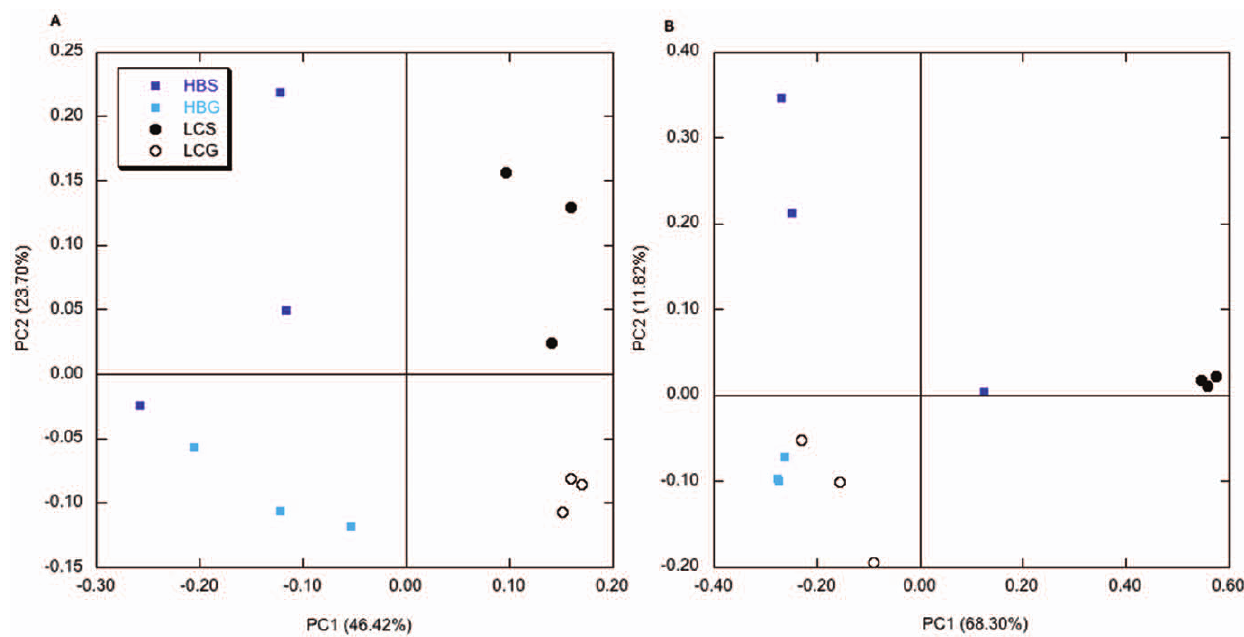
Figure 4. Principal components analysis of unweighted (A) and weighted (B) UniFrac distances for sequences derived from the CloVR pipeline for each of the replicate Hackberry Bay (HB) and Lake Caillou (LC) stomach (S) and gut microbiomes (G).